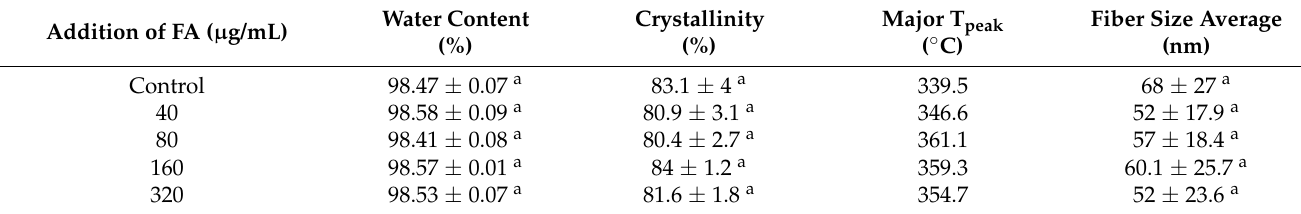
Table 1. Material properties of bacterial cellulase (BC) samples.